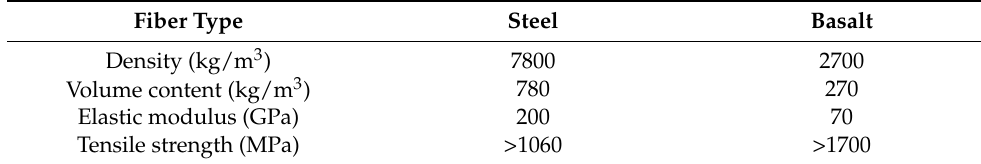
Table 1. Mechanical properties of